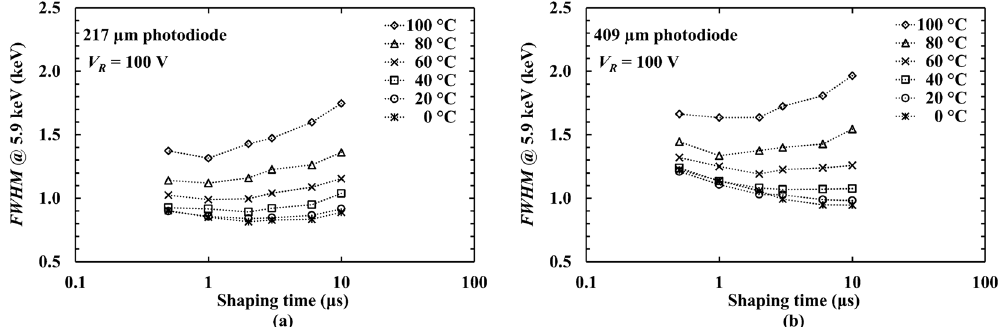
Figure 5. Measured FWHM at 5.9 keV as functions of shaping time for the Al 0.52 In 0.48 P photodiodes based spectrometers ( a ) 217 μ m diameter photodiode ( b ) 409 μ m diameter photodiode across the temperature range of 0 °C to 100 °C. The dotted lines are guides for the eyes